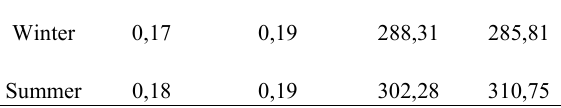
Table 3. Environmental variables differences between Pampa Biome site and Barrax site.